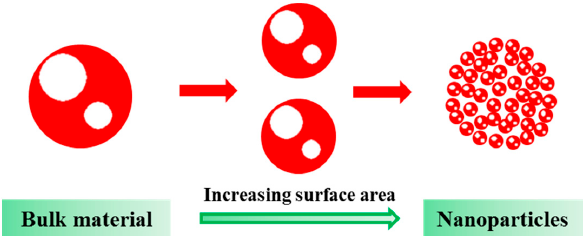
Figure 2. FESEM images of some commonly used NPs: ( a ) TiO 2 ; ( b ) Al 2 O 3 ; ( c ) NiO; ( d ) SiO 2 [16].